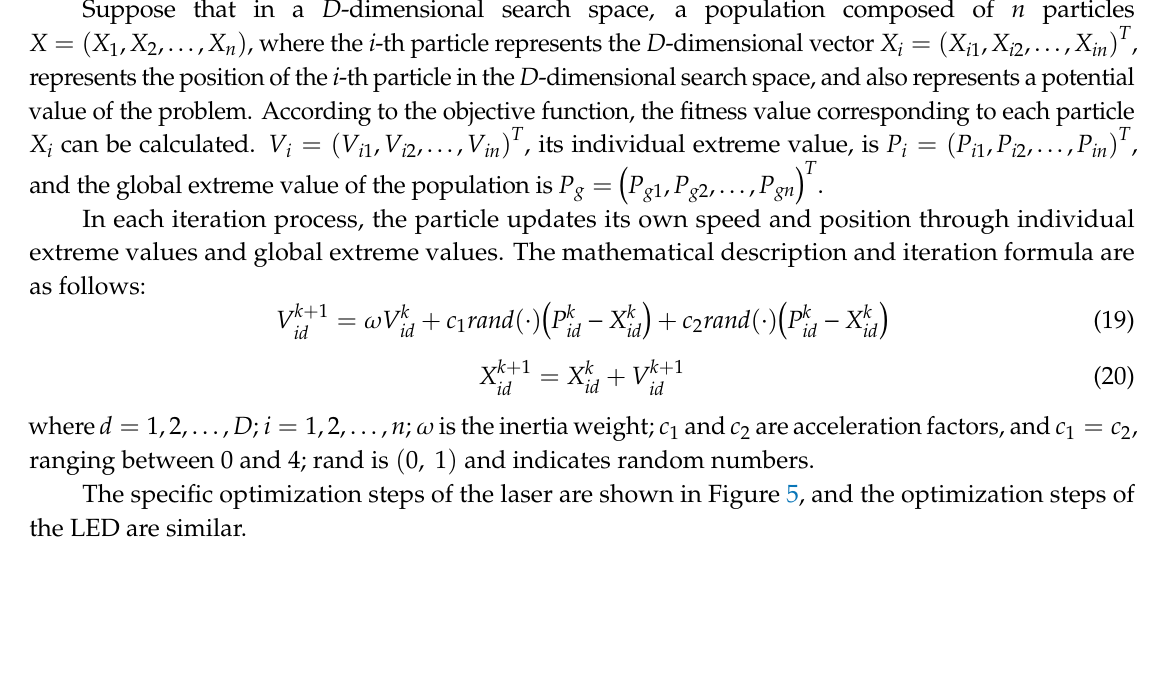
Figure 4. Schematic diagram of particle swarm algorithm.